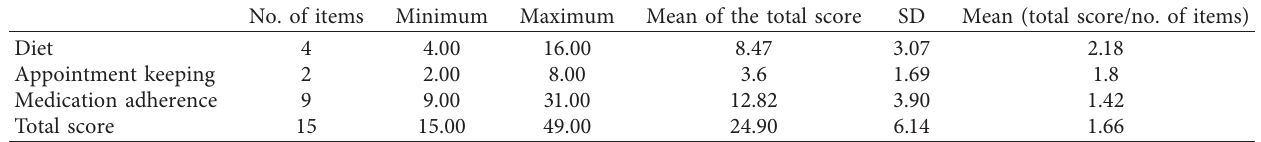
Table 3: Domains of the Hill-Bone Compliance to High Blood Pressure Therapy